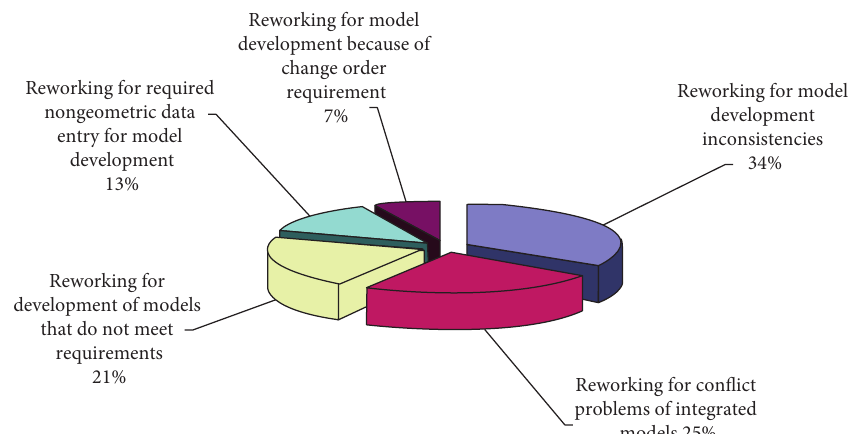
Figure 9: The major problems related to the reworking of BIM models development during the collaborative